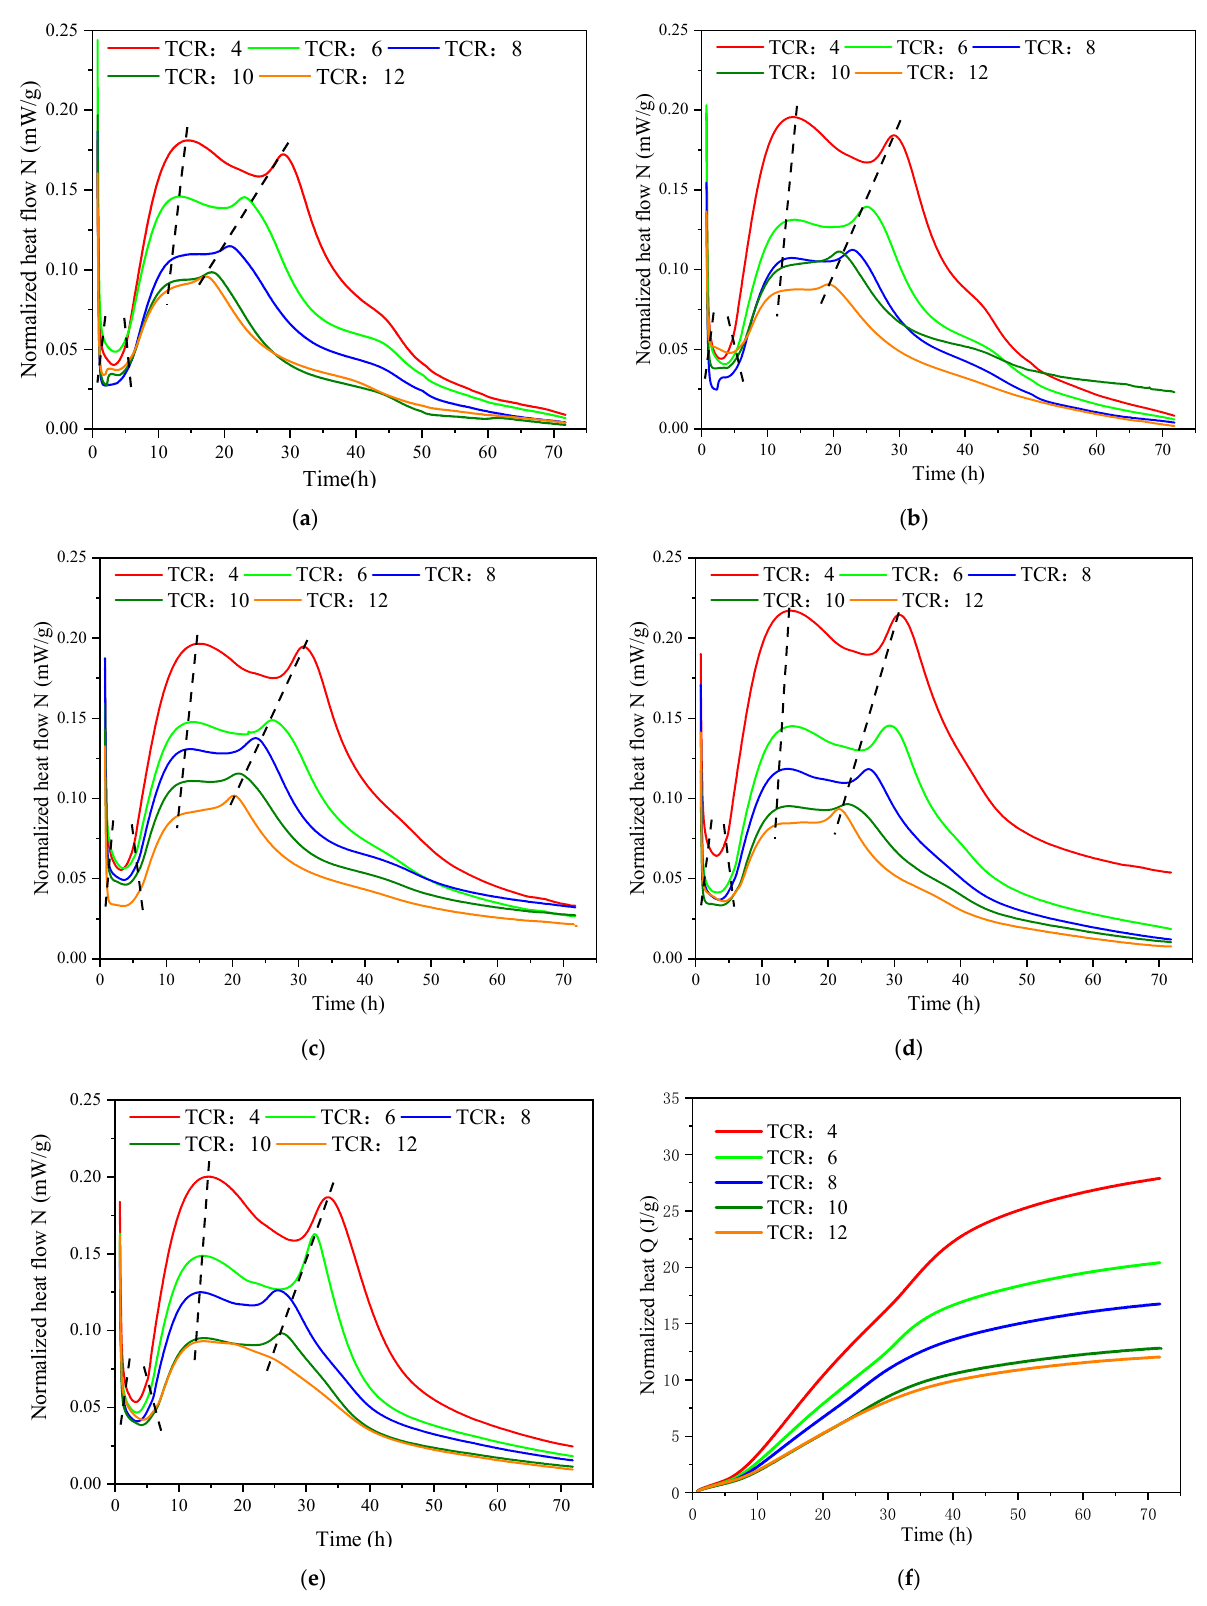
Figure 5. Hydration heat release rate curve: ( a ) SC = 68%, ( b ) SC = 70%, ( c ) SC = 72%, ( d ) SC = 74%, ( e ) SC = 76%, and total heat release: ( f ) SC = 72% of CSTB under different TCRs.